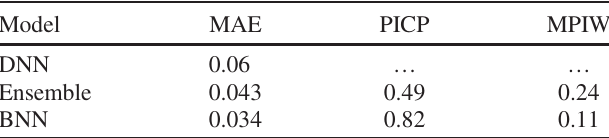
TABLE I. Comparison of models for SPEAR3 measured data.